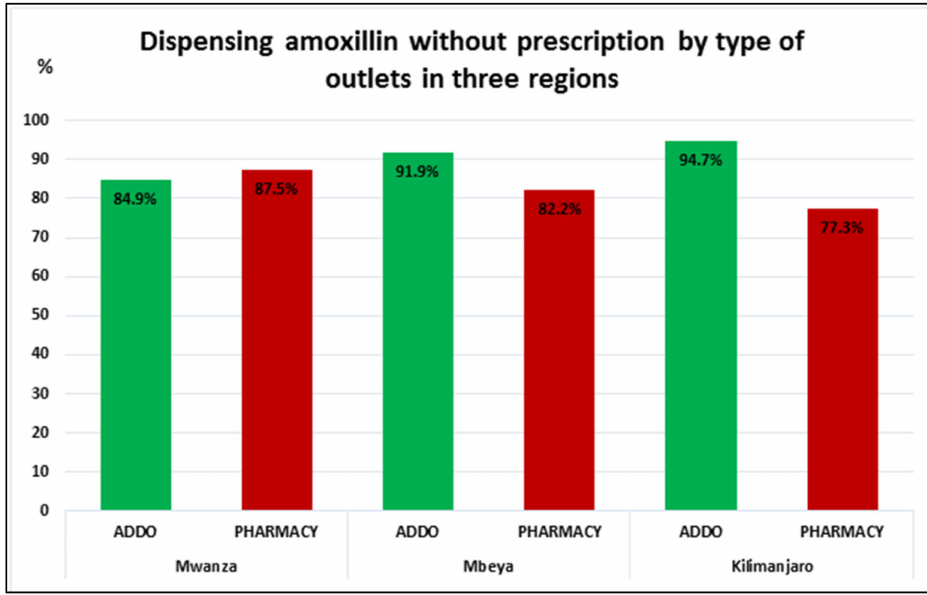
Figure 3. Proportion of sellers dispensing without prescription, according to types of outlets across three